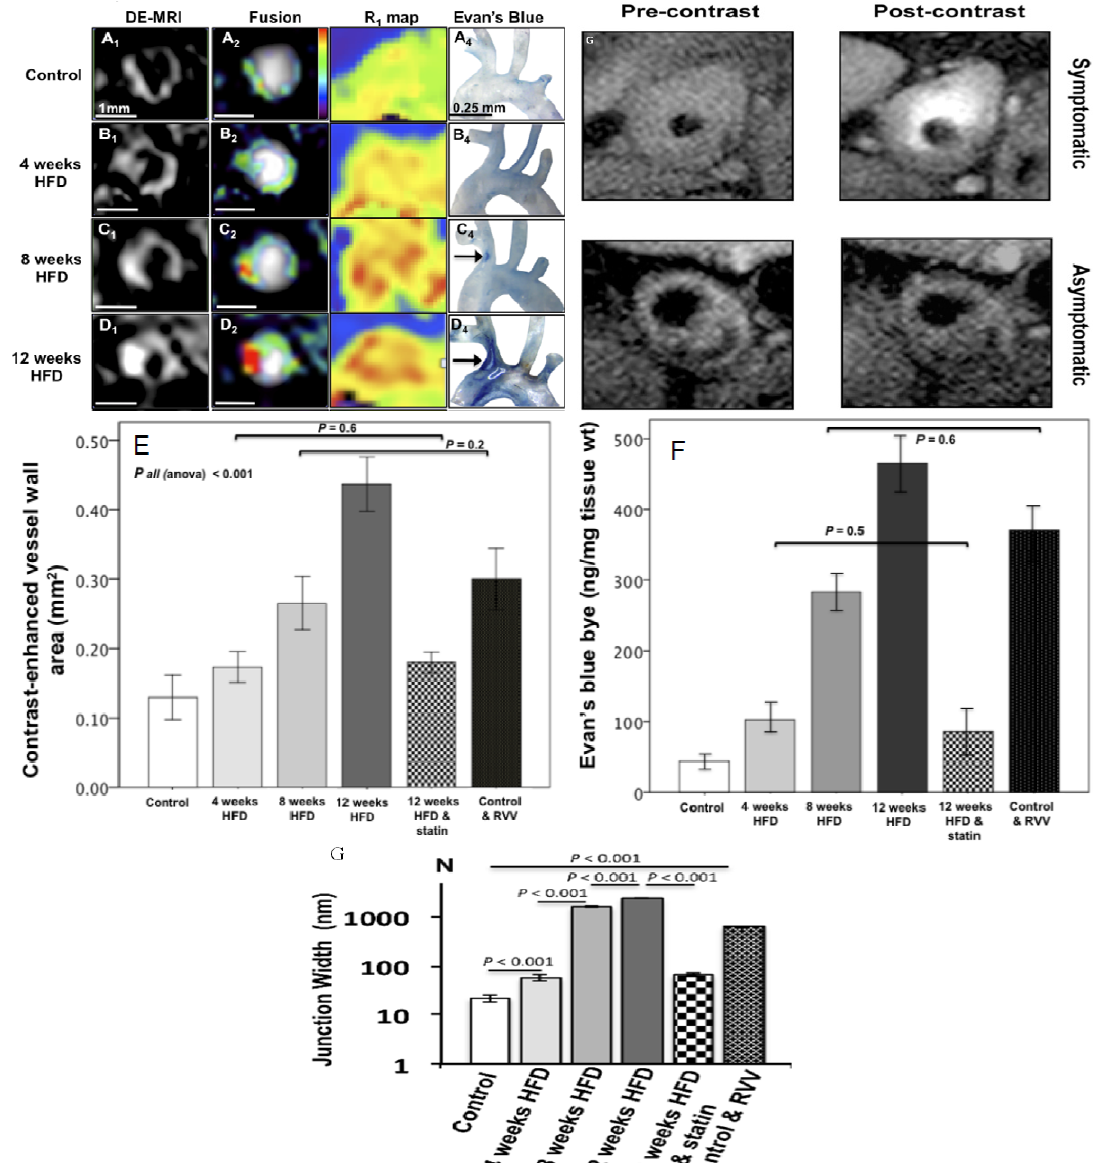
Figure 6. Late gadolinium enhancement (LGE) MRI and T permeability throughout the course of plaque development in high fat diet (HFD) fed apoE − / − mice using an albumin binding contrast agent, gadofosveset, ( A A – D ). Evan’s Blue dye staining of the artic arch and brachiocephalic artery shows good 3 3 – D ). Quantification of contrast enhancement on LGE MRI ( E ) was also in agreement ( A 4 4 good agreement with Evan’s Blue dye quantification ( F ). Gap junction width measured by transmission electron microscopy (TEM) showed a significant increase after the commencement of HFD and normalization in animals treated with statins ( G ) [16]. TEM of endothelial cell (EC) morphology ( H ) showed gradual disease development starting with vacuolation and almost complete EC denudation after 12 weeks of HFD and normalization in mice treated with statins. Clinical data (G) demonstrate increased gadofosveset uptake in patients with symptomatic carotid artery disease, which correlated with increased neovessel density and macrophage count (adapted from Phinikaridou)